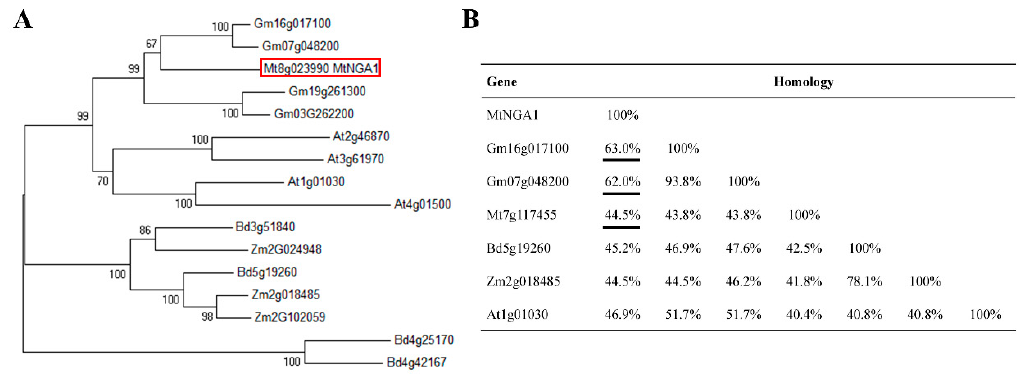
Figure 1. Phylogenetic tree analysis and homologous relation between NGATHA1 (NGA1) proteins from di ff erent species. ( A ) Phylogenetic tree analysis of 16 NGA1 proteins. Sequences were obtained from the Plant Transcription Factor Database (PlantTFDB). The tree was constructed using the neighbor-joining method with MEGA6.0 software. ( B ) Sequence homology of NGA1 proteins in the indicated species. MtNGA1 in M. truncatula was boxed. Gene accession numbers: MtNGA1 (Mt8g023990); Arabidopsis thaliana (At): At2g46870, At3g61970, At1g01030, At4g01500; Medicago truncatula (Mt): Mt7g117455; Glycinemax (Gm): Gm16g017100, Gm07g048200, Gm19g261300, Gm03g262200; Zea